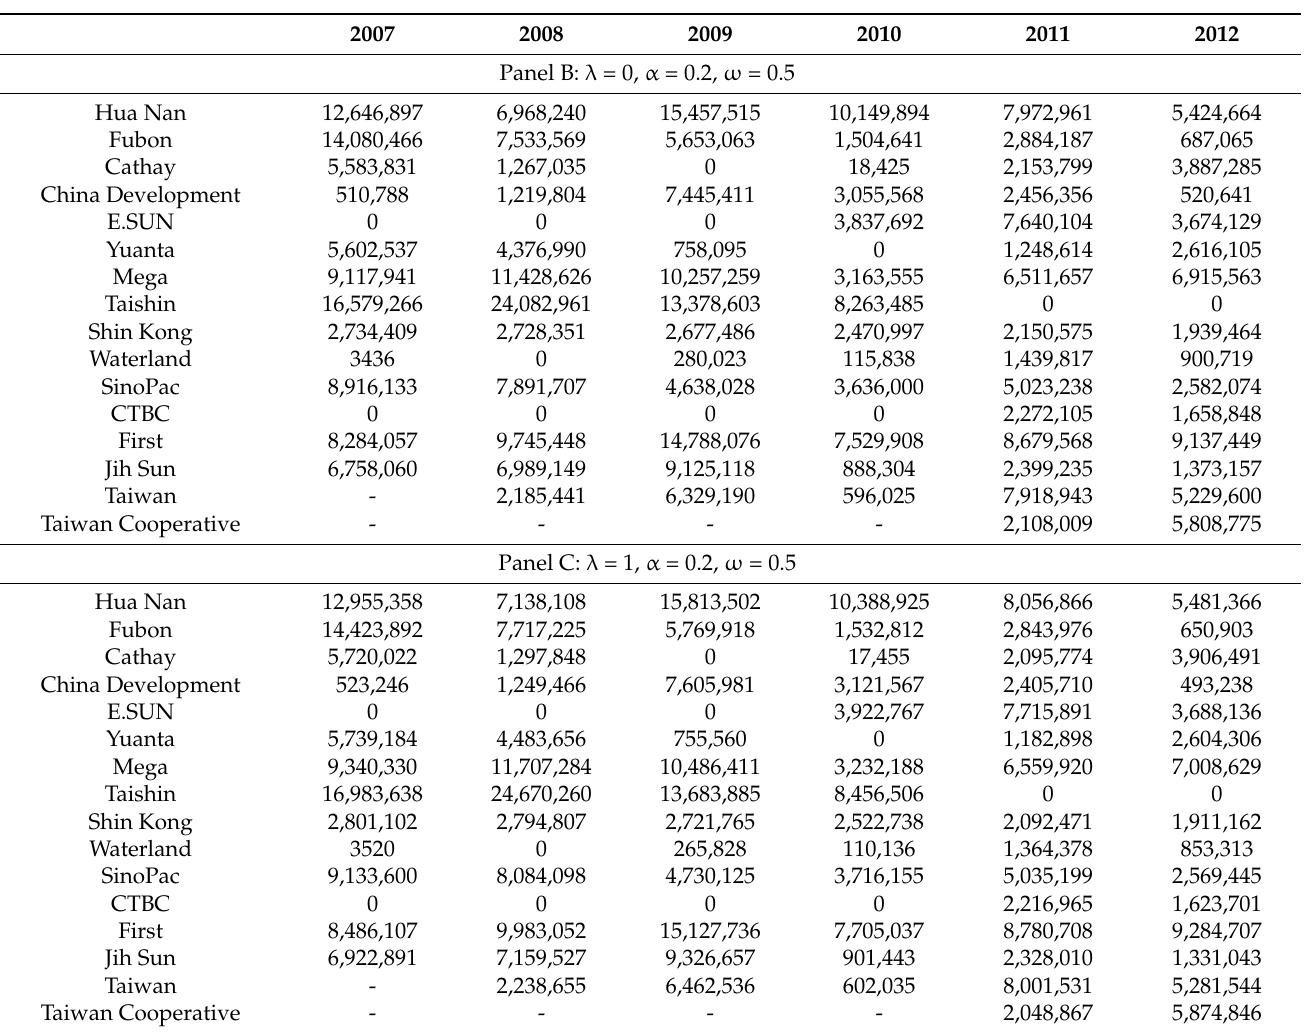
Table A1. Cont. 2007 2008 2009 2010 2011 2012 Panel B: λ = 0, α = 0.2, ω = 0.5